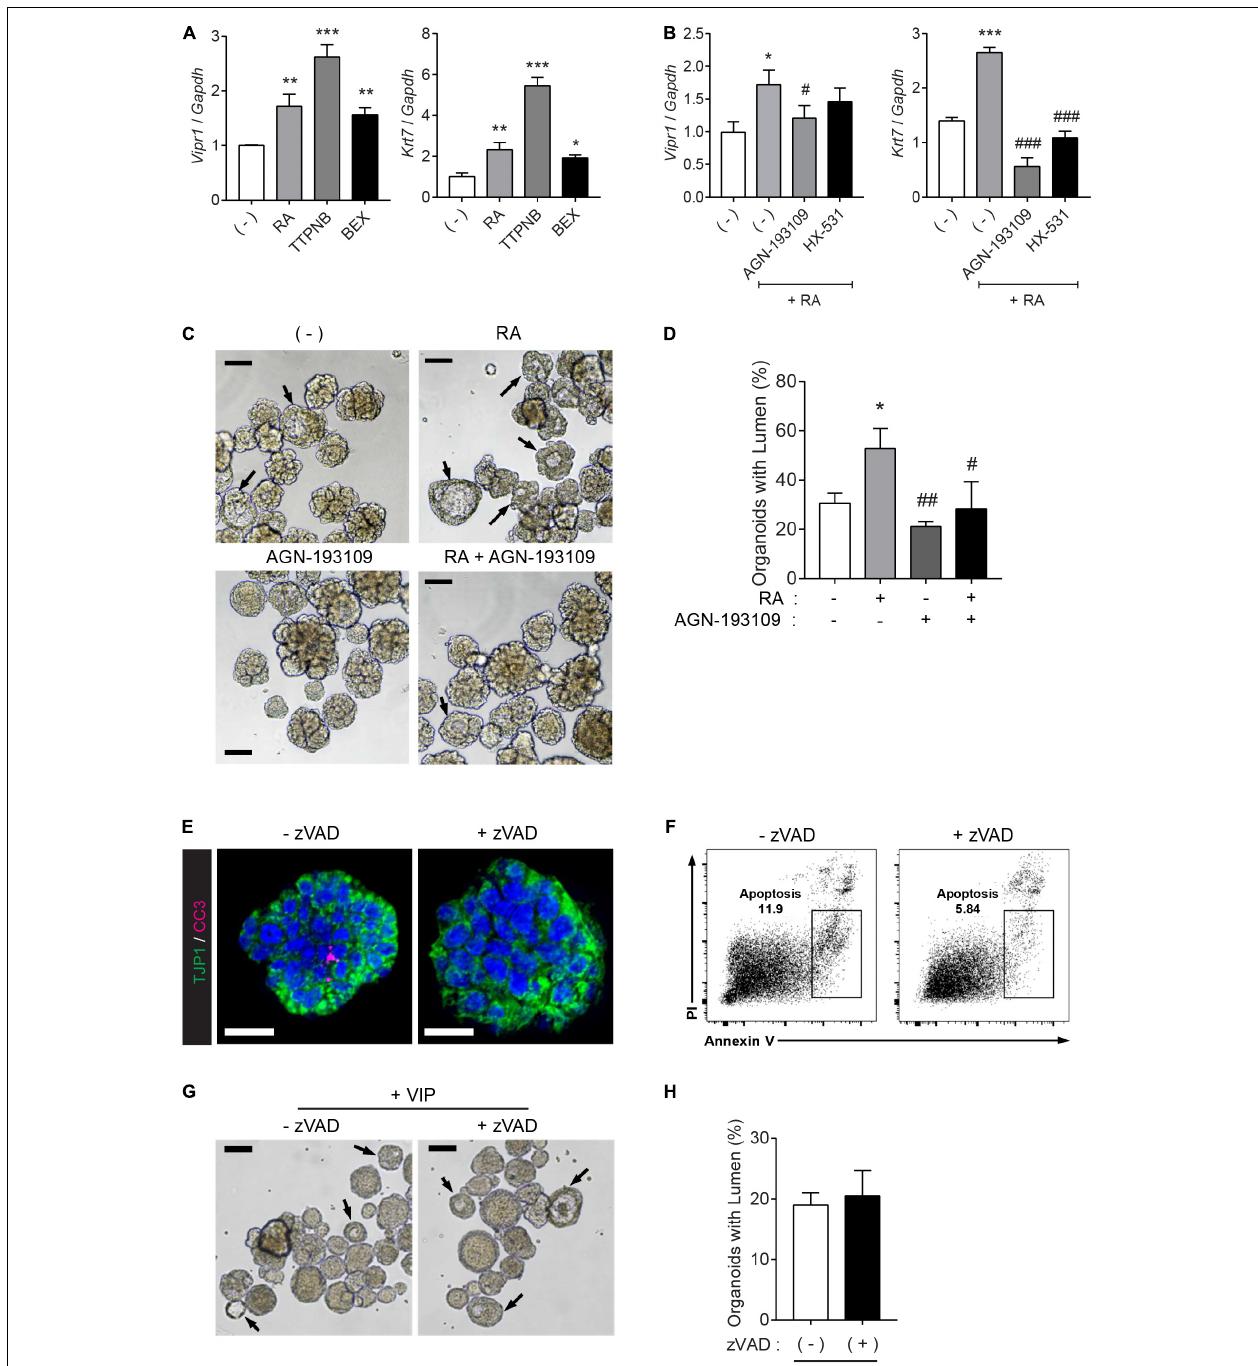
FIGURE 4 | RAR activation induces lumen formation in SMG organoids. (A) SMG organoids were cultured with 300 nM RA, TTNPB (RAR agonist), or bexarotene (RXR agonist) for 7 days and subjected to qRT-PCR for the detection of Vipr1 and Krt7 expression ( n = 4). (B) SMG organoids were treated with RA (300 nM), RA + 3 µ M AGN-193109 (RAR antagonist), or RA + 3 µ M HX (HX-531, RXR antagonist) throughout the culturing period and subjected to qRT-PCR for the detection of Vipr1 and Krt7 expression ( n = 4). (C–D) SMG organoids were treated with RA (300 nM), AGN-193109 (3 µ M), or both. The organoids were treated with VIP (200 nM) on day 2 for lumen formation. After 3 days, lumen formation was observed via microscopic images (C) . Black arrows indicate organoids containing visible lumen. The proportion of organoids with lumen were calculated and statistically analyzed (D) ( n = 3). Scale bars indicate 100 µ m in (C) . (E) SMG organoids were treated with 50 µ M z-VAD-FMK, a pan-caspase inhibitor, for 2 days, followed by whole-mount immunostaining with antibodies against CC3 (cleaved caspase-3) and TJP1 (ZO-1). DAPI (blue) was used for counterstaining the nucleus. Scale bars indicate 20 µ m. (F) Apoptotic cell death (Annexin-V + PI − ) in SMG organoids